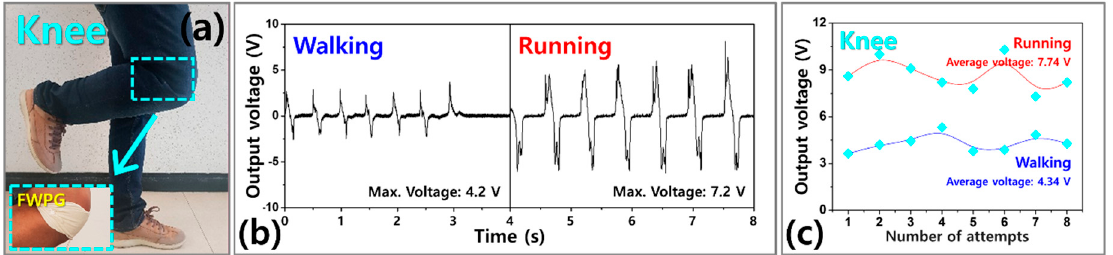
Figure 9. ( a )Photograph of an attached FWPG from the knee. ( b ) Output voltage of the FWPG from the knee when walking and running. ( c ) Average voltage of the FWPG from the knee when a human is walking and running.